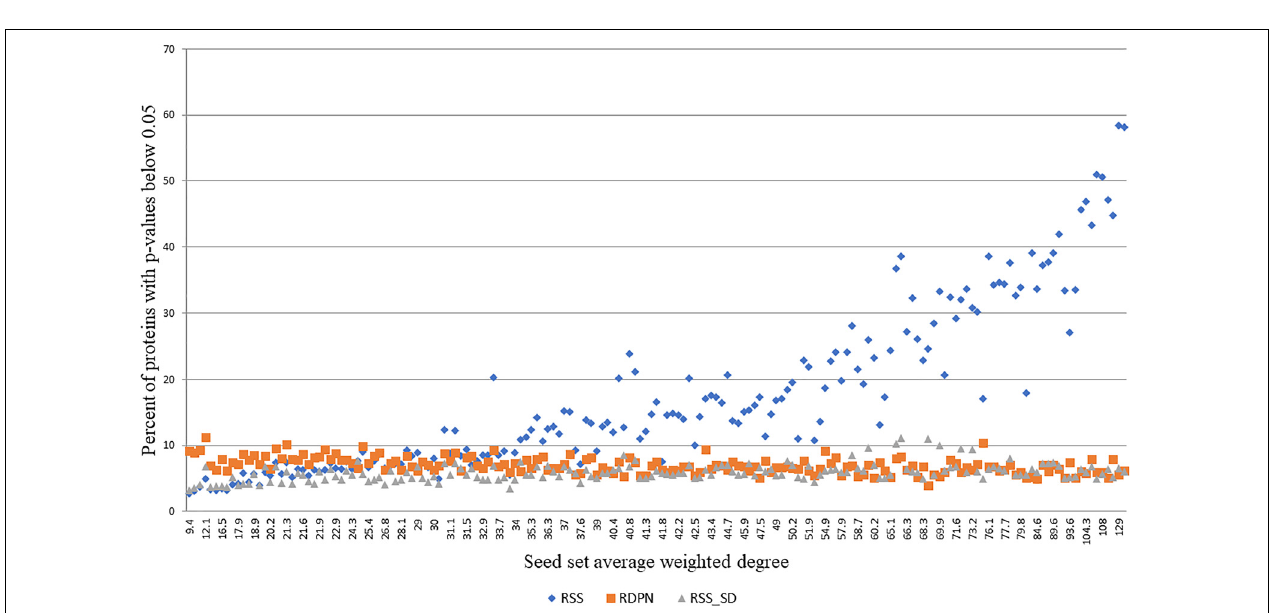
FIGURE 3 | Average rank vs. weighted degree of candidate proteins. Depicted here are ranks based on seed sets from five arbitrary diseases in the Menche-OMIM set (Menche et al., 2015); bins contain approximately equal numbers of proteins. Ranks are derived from the methods’ scores the better the score the lower the rank.